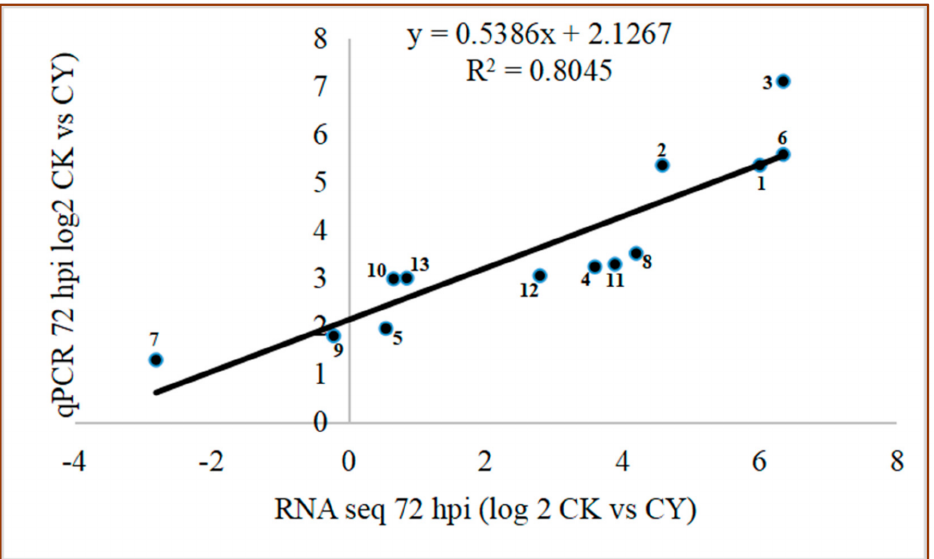
Figure 7. The comparison of relative gene expression level between RNA seq and RTq − PCR. CK = Control, CY = P. anomala induced with chitosan (1% w / v ), 72 hpi = 72 h post